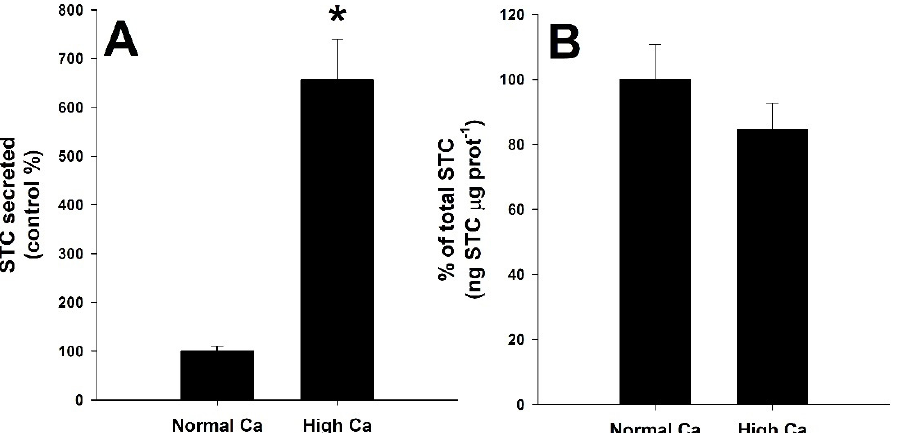
Figure 2. Stanniocalcin (STC) ex vivo secretion ( A ) and production ( B ) from the corpuscles of Stannius of the gilthead seabream, Sparus aurata , after treatment with normal calcium concentration (1.46 mM Ca 2+ ) or high calcium (2.92 mM Ca 2+ ). Basal STC secretion for the control group is 0.16 ± 0.04 ng STC µ g prot -1 h − 1 . Values are referred to as % from the control group (mean ± SEM) for single independent experiments ( n = 19 per group). Asterisks (*) indicate significant differences from the control group (Student ´ s t -test, p < 0.05).